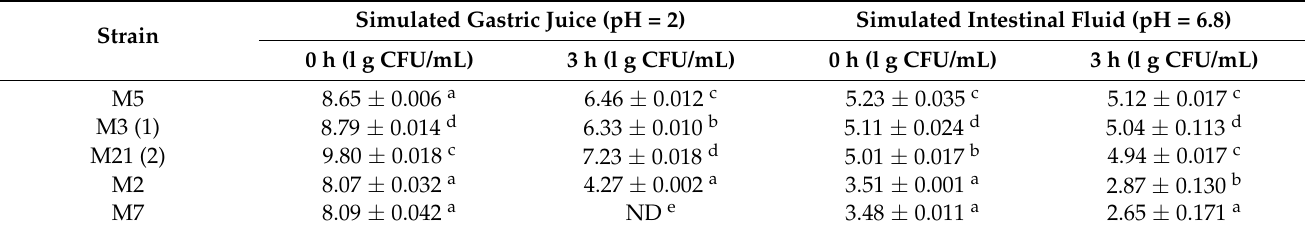
Table 7. Tolerance of LAB simulated gastrointestinal fluid.